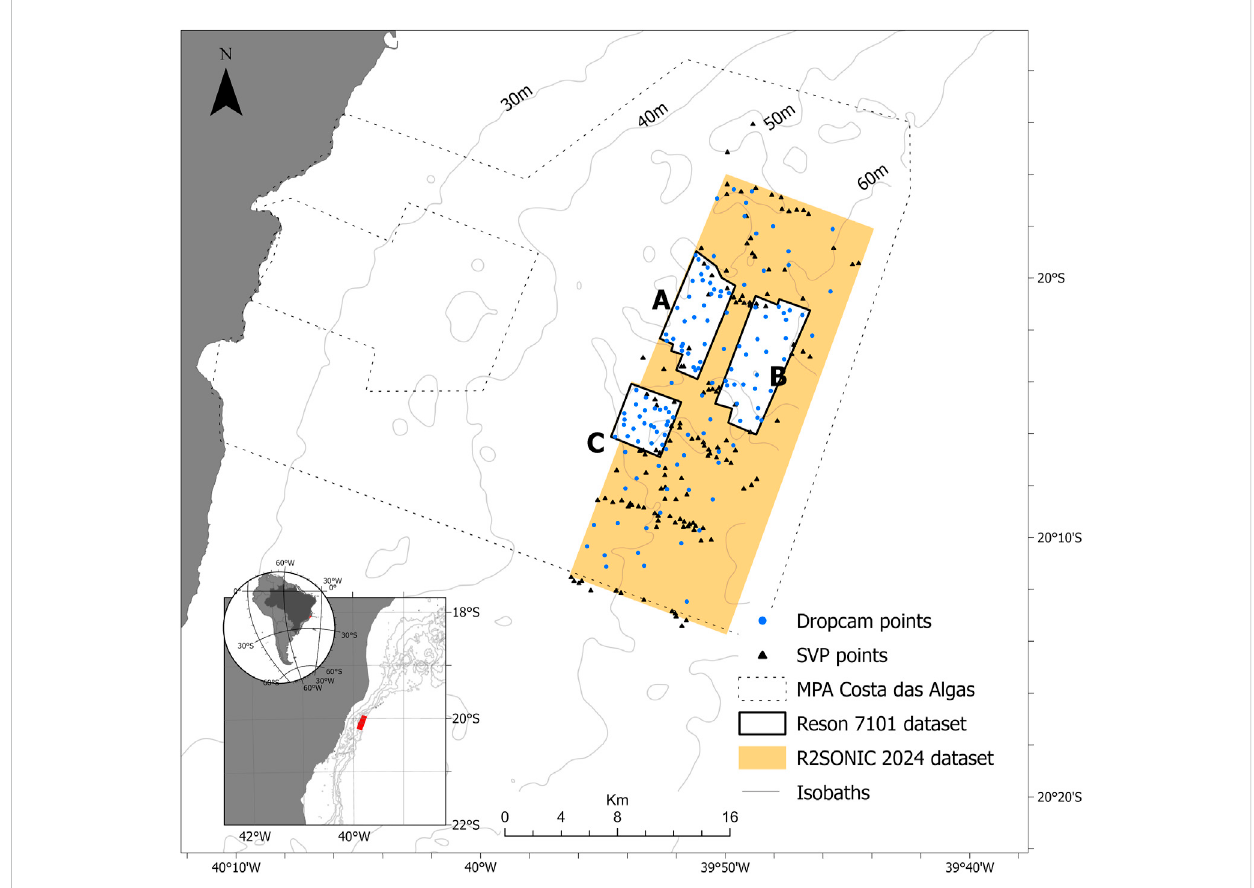
FIGURE 1 Map showing the study area within the MPA Costa das Algas, including the multibeam survey area (Reson 7,101 and R2Sonic 2024), the Dropcam sampling points and the SVP/CTD stations. (A – C) are areas surveyed by Reson 7,101. Isobaths were obtained from Bastos et al. (2015). Datum: